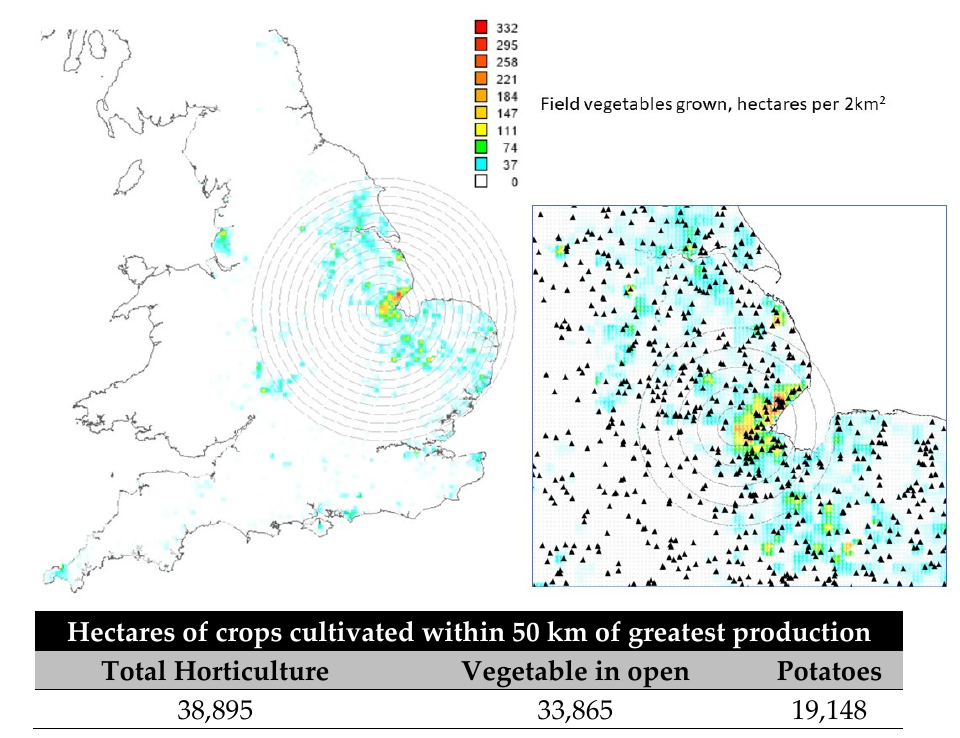
Figure 4. The density of field vegetables grown in England with specific focus on the regional distribution in Lincolnshire. The area of field vegetables (carrots, onions, brassicas, legumes, others) grown within 50 km of the greatest density of production is provided. The data are derived from the Defra AHS and FAME databases described in the text. The inset graphic shows the distribution of vegetable processing and trading companies within this region.